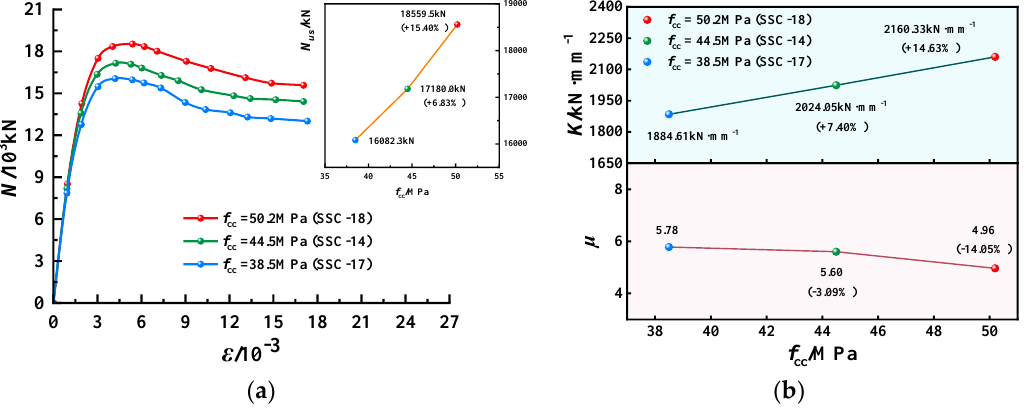
Figure 8. N - ε curves, K and µ of EGCSSCs with different f cc : ( a ) N - ε curves of specimens with cross-section height of 1000 mm. ( b ) K and µ of specimens with cross-section height of 1000 mm.